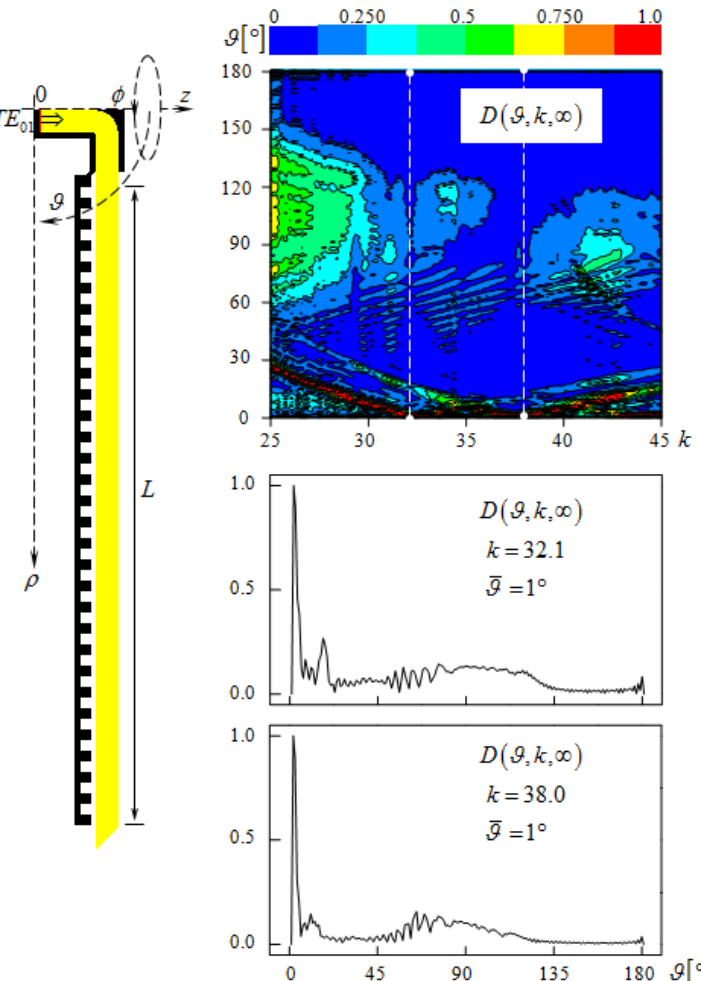
Figure 2. Radial diffraction radiation antenna. Radiation pattern D ( ϑ , k , ∞ ) in the frequency band 25 ≤ k ≤ 45 and at frequencies k = 32.1 and k = 38.0. L is a parameter that determines the size of the emitting